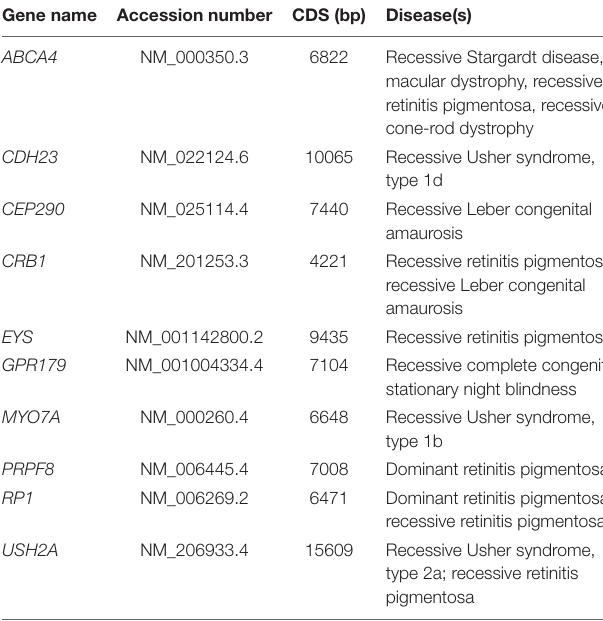
Representative list of genes associated with IRDs containing large coding sequences (CDS). Gene names are listed alphabetically, accession numbers